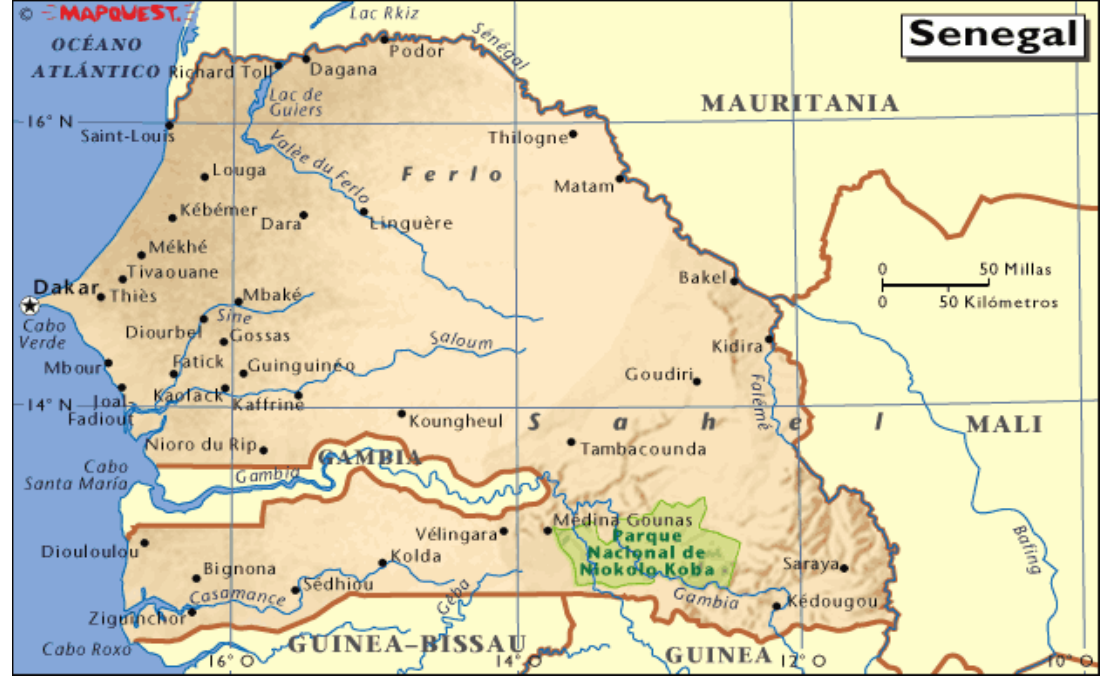
Figure 1: Map of Senegal (source:http://go.hrw.com/atlas/span_map/senegal.gif)